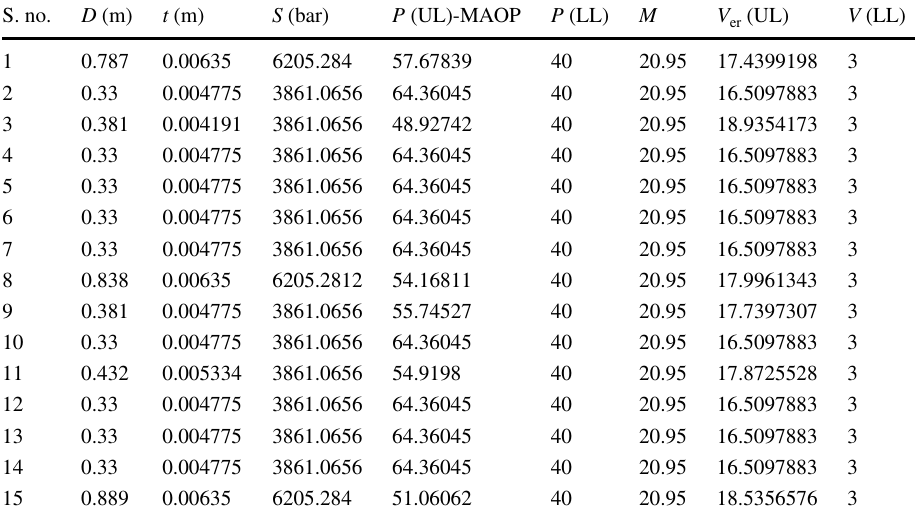
Table 4 Upper and lower limits of pressure and velocity in pipe